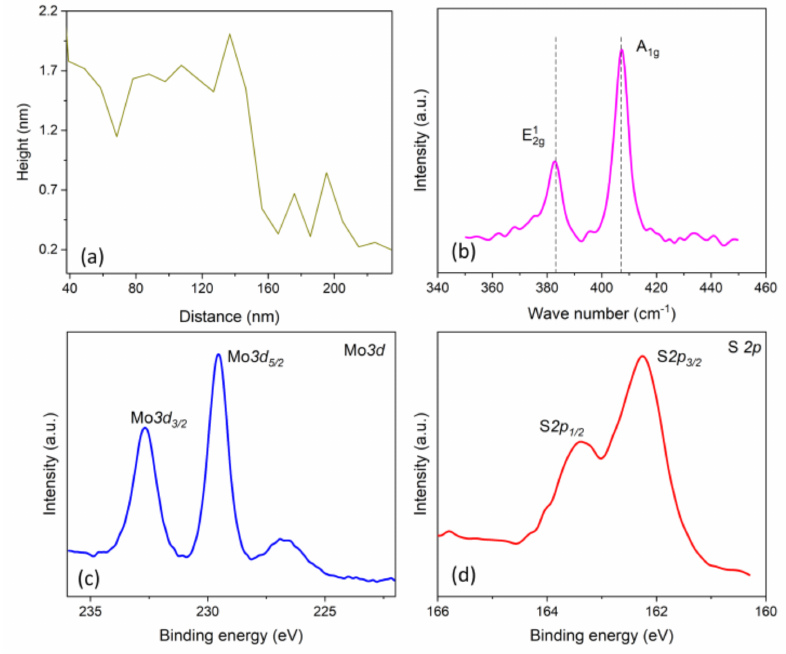
Figure 3. MoS 2 characterization results by ( a ) AFM, ( b ) Raman, and ( c , d ) XPS. The MoS 2 crystals formed on the substrate over the different types of quartz boat carrier of MoO 3 are shown in Figure 4. It can be noted that the MoS 2 crystal pieces did not spread over the target surface randomly and uniformly. Instead, they occurred intensively barely. More MoS 2 crystal pieces were achieved by using quartz boat carrier type A of MoO 3 . The downstream zone of the target substrate above MoO 3 carrier type A showed a greater intensity of MoS 2 crystal pieces. Substantial crystal grains appeared in the same zone on the substrate above the MoO 3 carrier type B, most of which, however, did not grow as big as those on the substrate above carrier type A. As for the substrate above the MoO 3 carrier type C, few crystal grains of monocrystal MoS 2 were found and they were not of a large